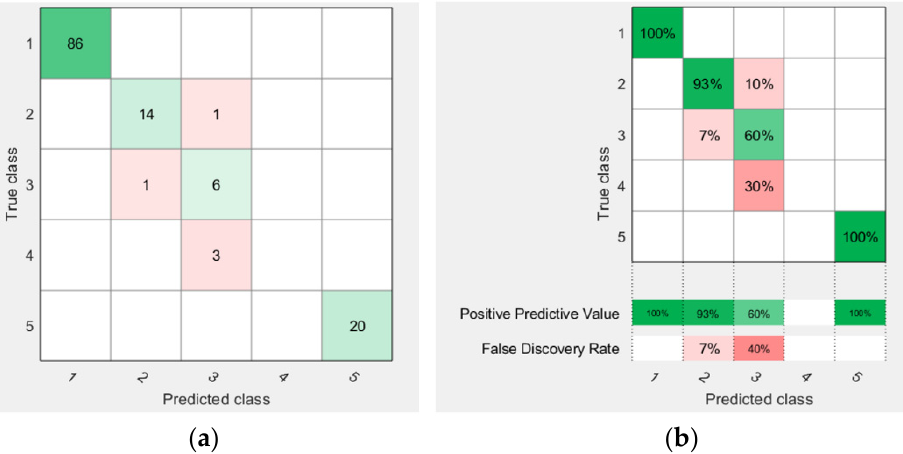
Figure 7. The confusion matrix of the classification accuracy of the decision tree classifier: ( a ) the correct number of the samples in each class and ( b ) the classification accuracy percentage of each class.